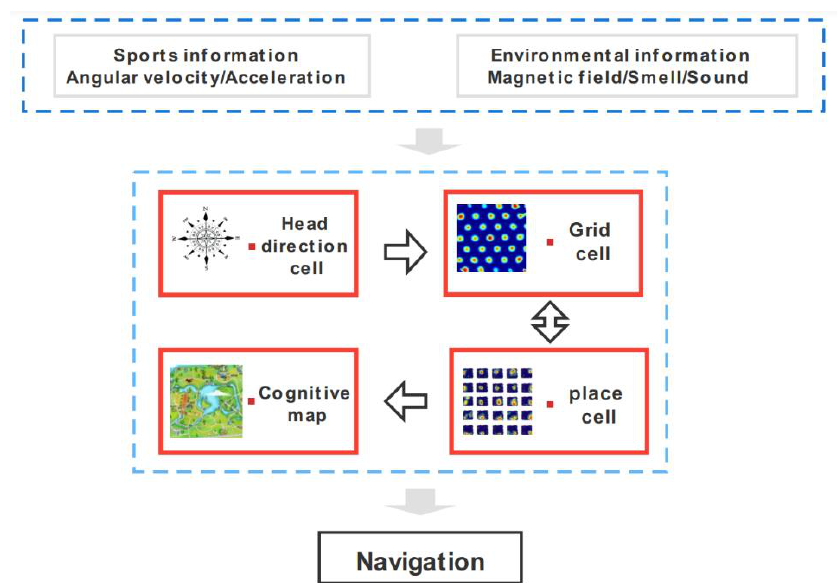
Figure 8. Schematic diagram of the mammalian brain navigation system.